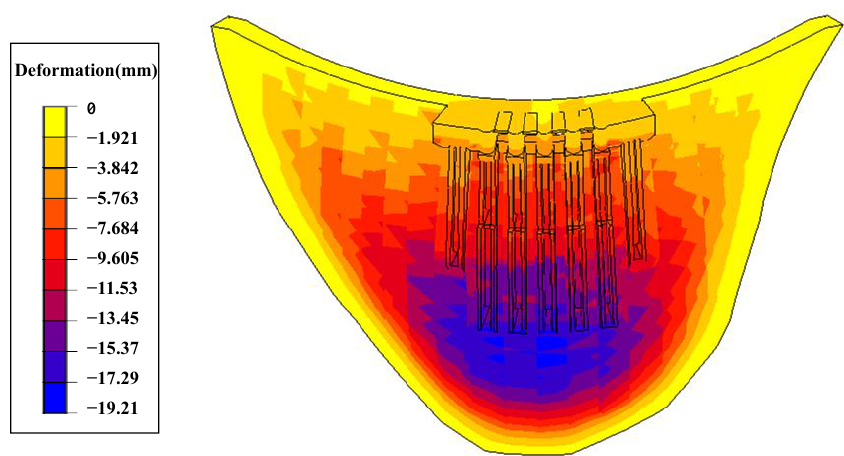
Figure 32. Tangential deformation of the super-high arch dam.